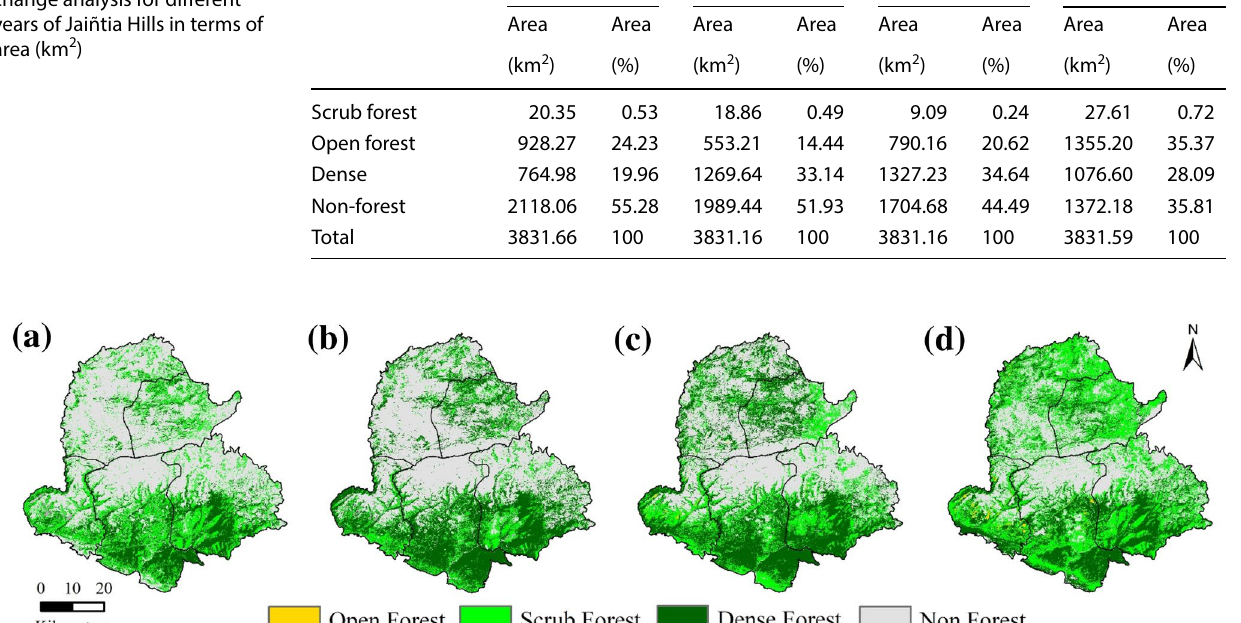
Table 2 Temporal land cover change analysis for different years of Jaiñtia Hills in terms of area (km 2 )